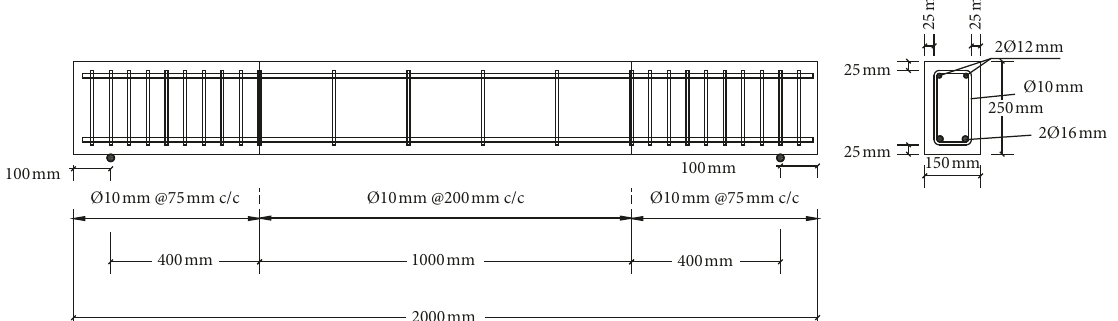
Figure 1: Dimensions and reinforcement details of the test beams.